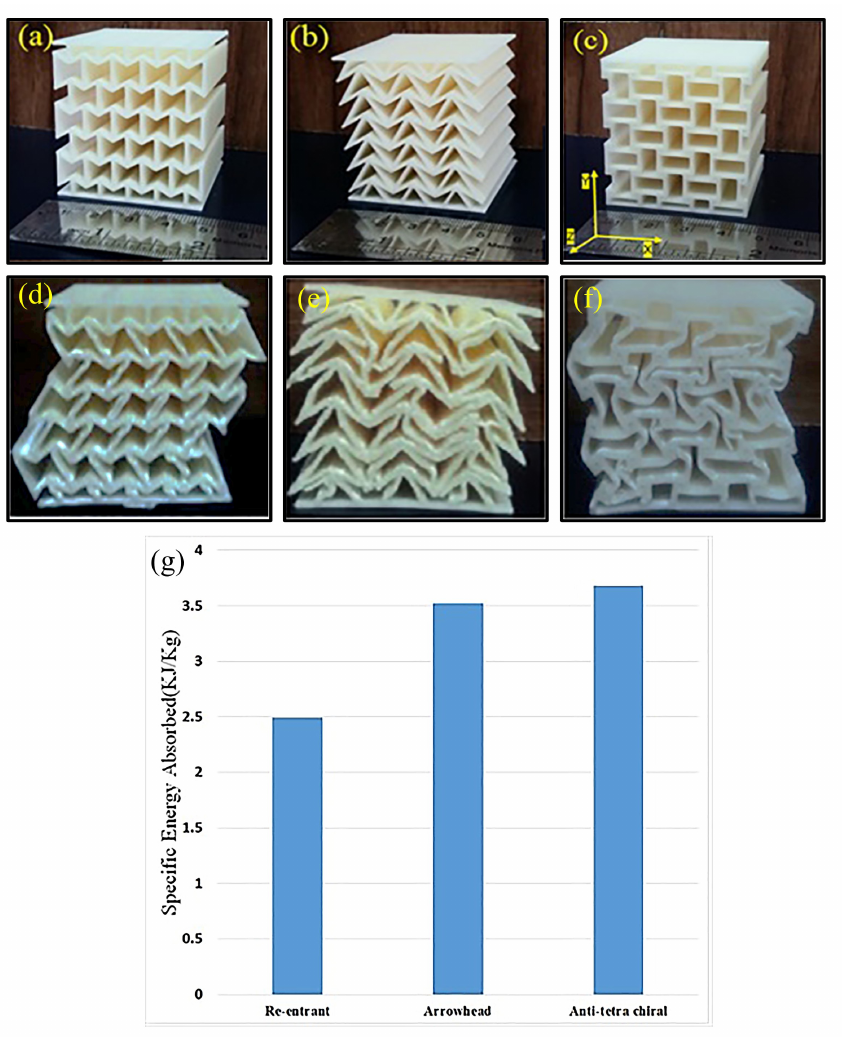
Figure 7. Auxetic 3D printed ABS structures: ( a ) re-entrant; ( b ) arrowhead; ( c ) anti-tetrachiral; ( d ) re-entrant after compression test; ( e ) arrowhead after compression test; ( f ) anti-tetra chiral af- ter compression test; and ( g ) specific energy absorption of the tested structures. Reprinted with permission from Ref. [100]. Copyright 2021,